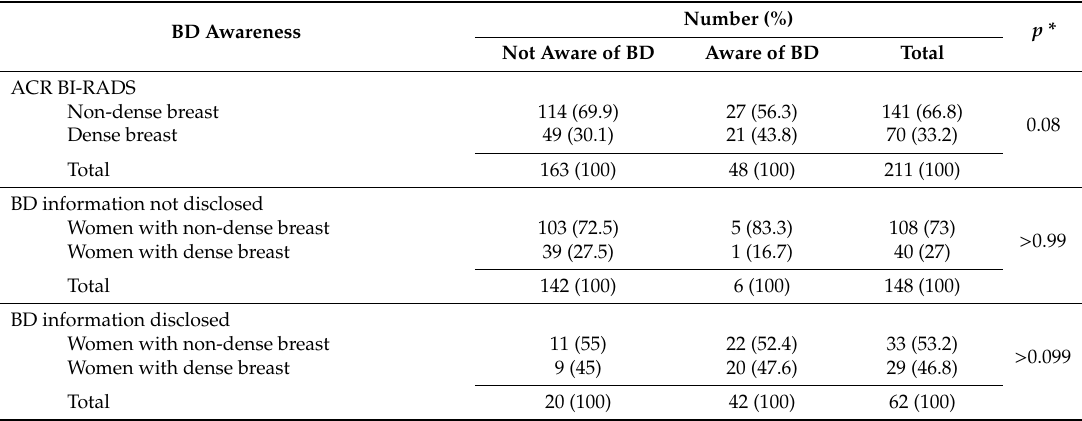
Table 2. Radiological evaluation of breast density and di ff erences in breast density (BD) awareness according to BD information